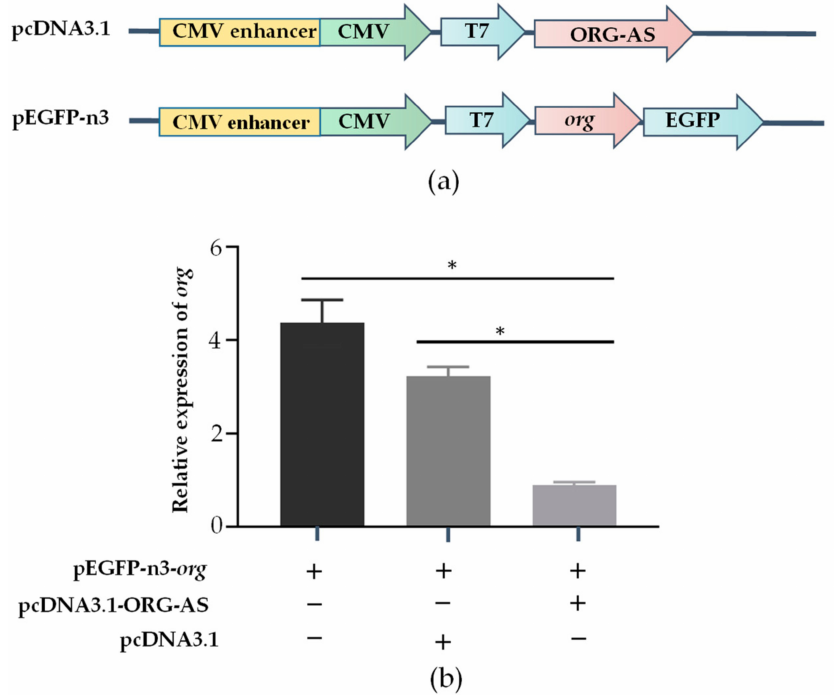
Figure 6. The effect of ORG-AS overexpression on org expression levels. ( a ) Construction of pcDNA3.1-ORG-AS and pEGFP-n3- org overexpression vectors; ( b ) After transfection of 293T cells, the expression level of org was detected and normalized to ACTINB expression, and the mean ± SEM from three independent individuals ( n = 3) is shown. * p <